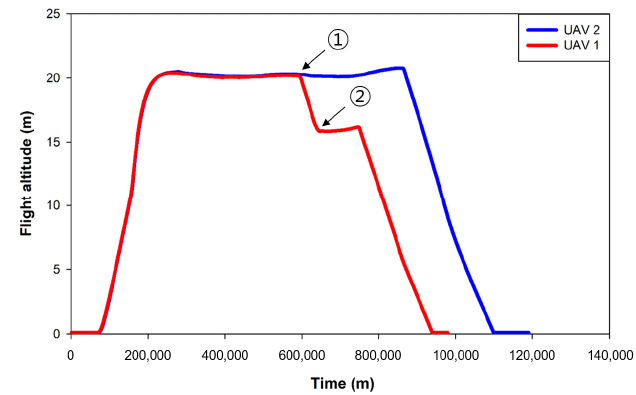
Figure 16. Flight altitude for each UAV during collision avoidance.